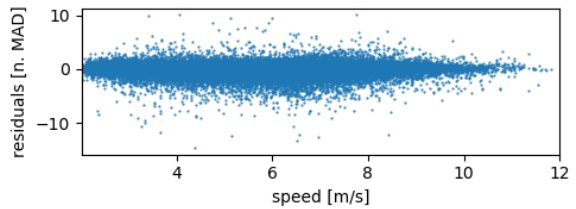
Figure 5. Observation residuals plotted by related